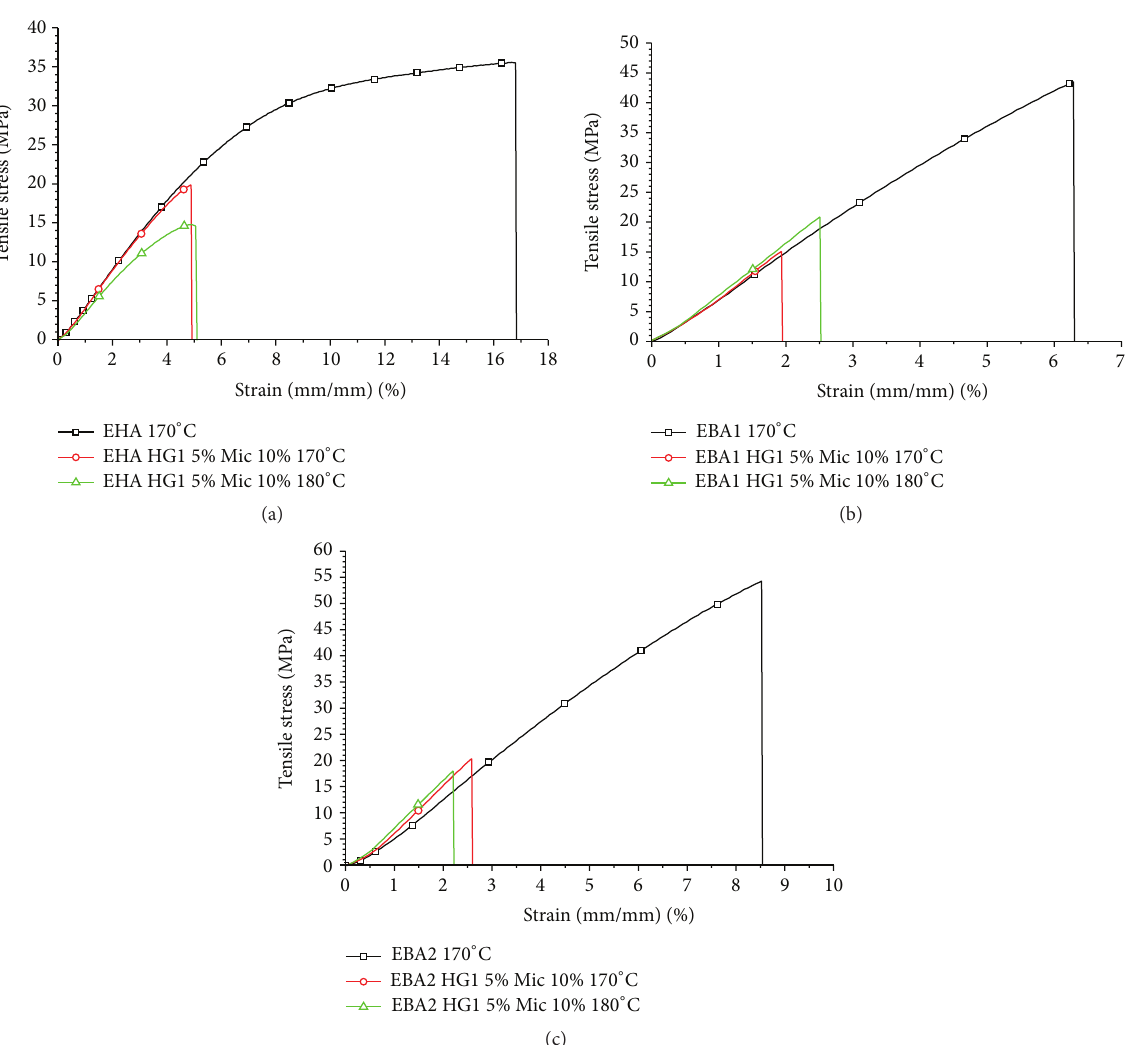
Figure 2: (a) Comparison of tensile stress-strain curves for neat EHA and EHA self-healing system at the different curing temperature. (b) Comparison of tensile stress-strain curves for neat EBA1 and EBA1 self-healing system at the different curing temperature. (c) Comparison of tensile stress-strain curves for neat EBA2 and EBA2 self-healing system at the different curing